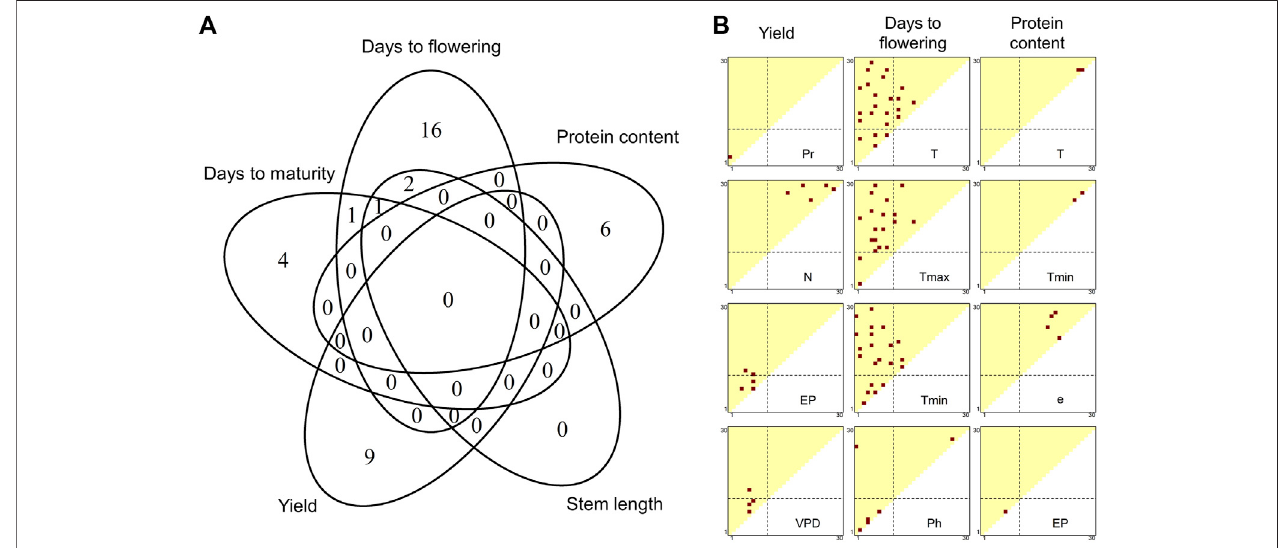
FIGURE 5 | Summary of chromosomal regions detected by genome-wide association mapping. (A) Number of chromosomal regions signi fi cantly detected by associationmappingforeachtrait. (B) Distributionsofmeteorologicalfactor/growthstagecombinationswheresigni fi cantassociationsweredetected.Reddotsindicate the combinations with signi fi cant associations. See Supplementary Figure S11 for the other traits and meteorological factors. The diagonal elements of the triangles correspondwiththe1stto30thgrowthstages,fromthelowerlefttotheupperright.Theoff-diagonalelementscorrespondtothegrowthperiodsthatspanmultiple stages,wherethe x and y axesdenotethestartandendoftheperiods,respectively.Thebrokenlinesindicate fl oweringtime.Abbreviations:T,meantemperature;Tmax, maximum temperature; Tmin, minimum temperature; Pr, precipitation; e, vapour pressure; VPD, vapour pressure de fi cit; N, hours of sunshine; EP, potential evapotranspiration; Ph, photoperiod.